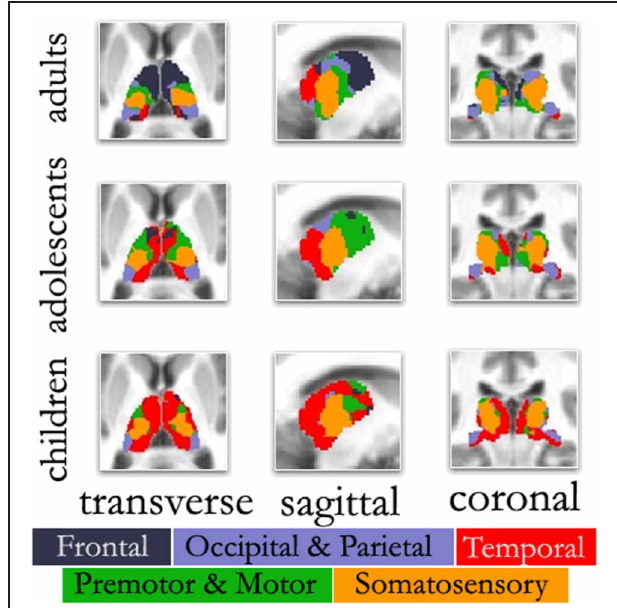
FIGURE 3 | Changes in thalamo-cortical connectivity across age. The color-coded thalamus, based on the winner take all strategy (Zhang et al., 2008), in adults shows a functional organization that is remarkably similar to known nuclear groupings in the primate thalamus. However, the picture is different in adolescents and children. In both adolescents and to a greater extent children, thalamo-temporal interactions encompass a greater portion of anterior and midline thalamus, while the frontal lobe interactions encompass much less of the anterior portions of the thalamus. In children, thalamo-temporal interactions not only encroach on areas that, in adults, are dominated by thalamo-frontal interactions, but also impinge on thalamic zones that later become functionally more connected with motor/premotor, somatosensory, and occipical/parietal cortex; Transverse Z = + 8, Sagittal X = − 12, Coronal Y = −